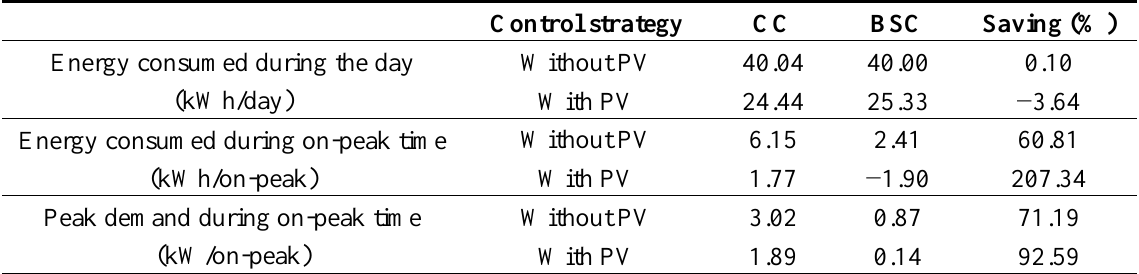
Figure 12. Temperature variation in solar hot water tank and buffer storage tank, and heat pump electric power for space-heating operation mode test with CSC. Table 5. Comparison of electricity consumption and peak demand for two test days using conventional and peak reduction control strategies in space-cooling-mode tests(BSC in space cooling mode).